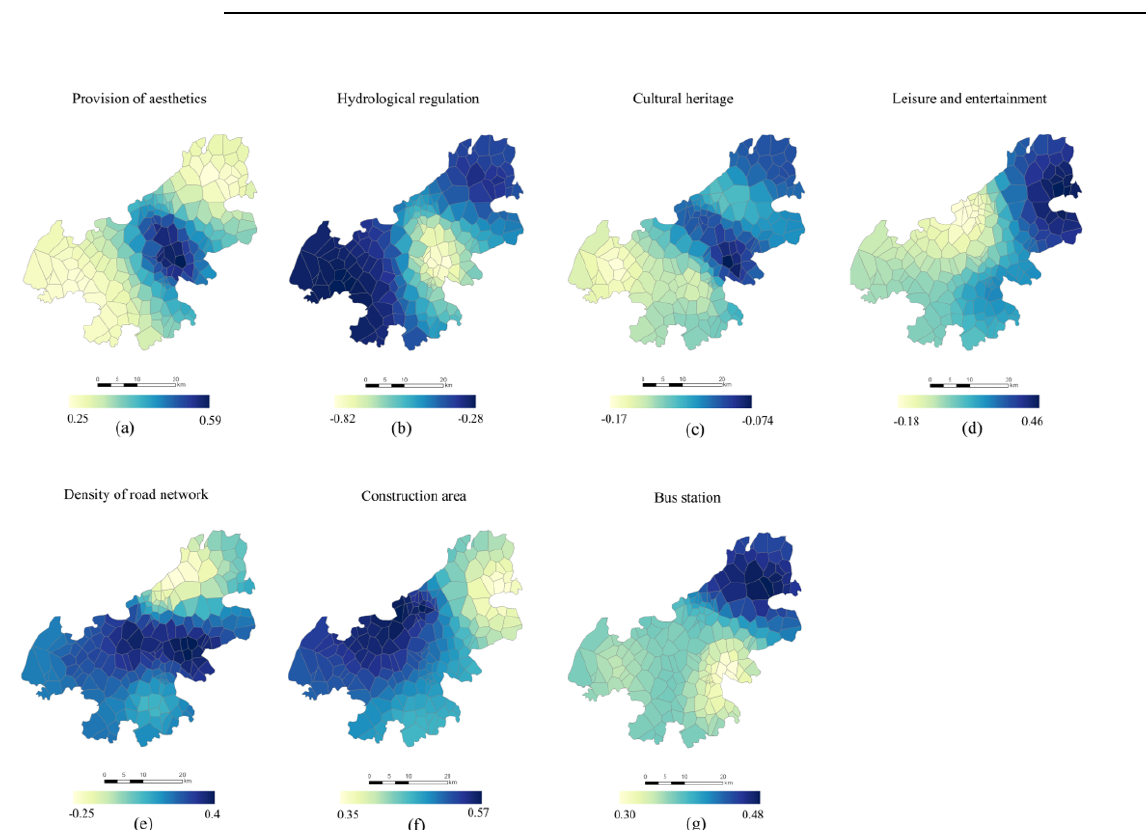
Figure 7. Spatial patterns of regression coefficients between human activities and the factors of LFs, ( a ) Provision of aesthetics, ( b ) Hydrological regulation, ( c ) Cultural heritage, ( d ) Leisure entertainment, ( e ) Road network density, ( f ) Construction area, ( g ) Bus station.